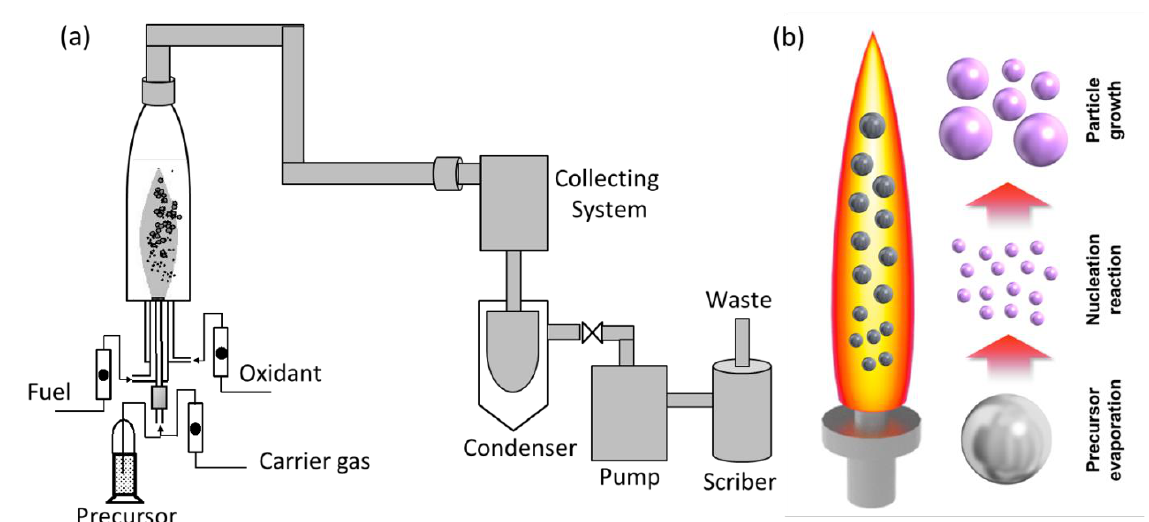
Figure 2. ( a ) General configuration of the flame synthesis; ( b ) particle formation process.